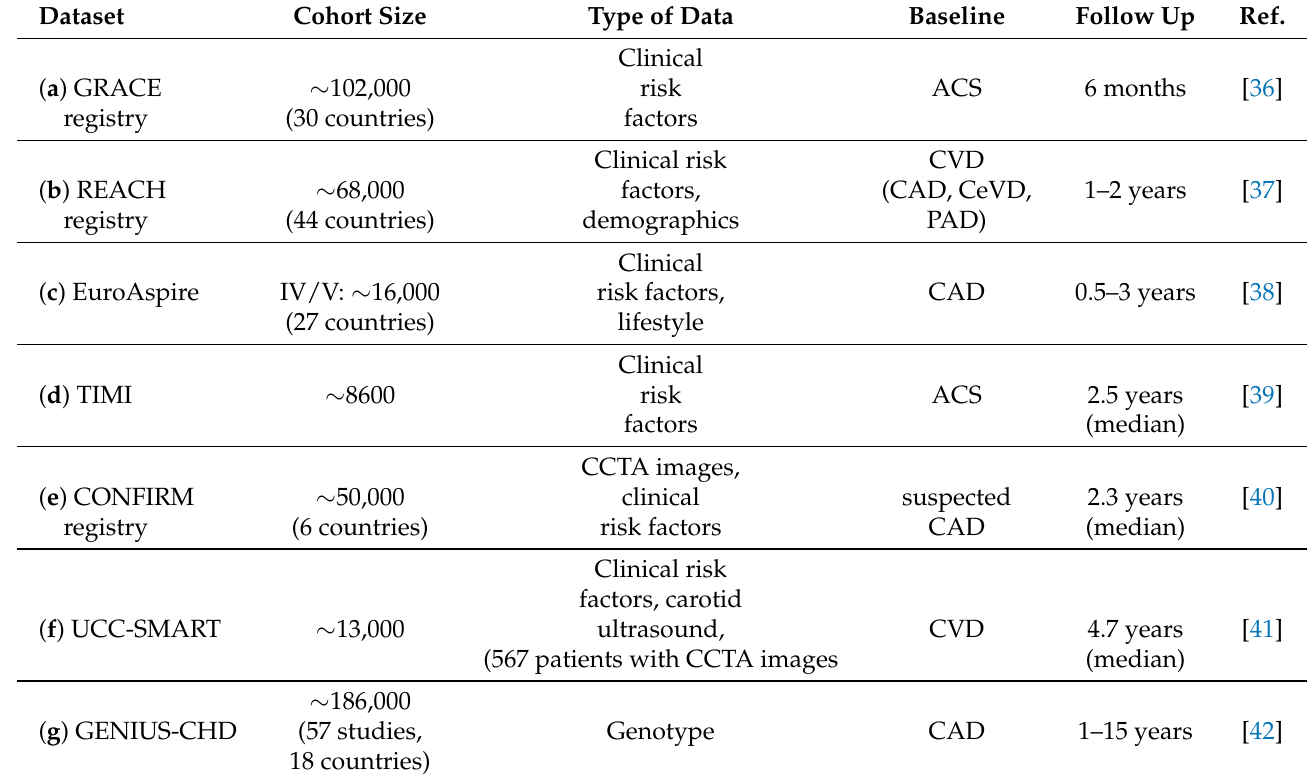
Table 3. Table of clinical, genetic, and imaging datasets used to predict risk for recurrent events. CCTA—coronary computed tomography angiography; CVD—cardiovascular disease; CAD—coronary artery disease; CeVD—cerebrovascular disease; PAD—peripheral artery disease; ACS—acute coronary